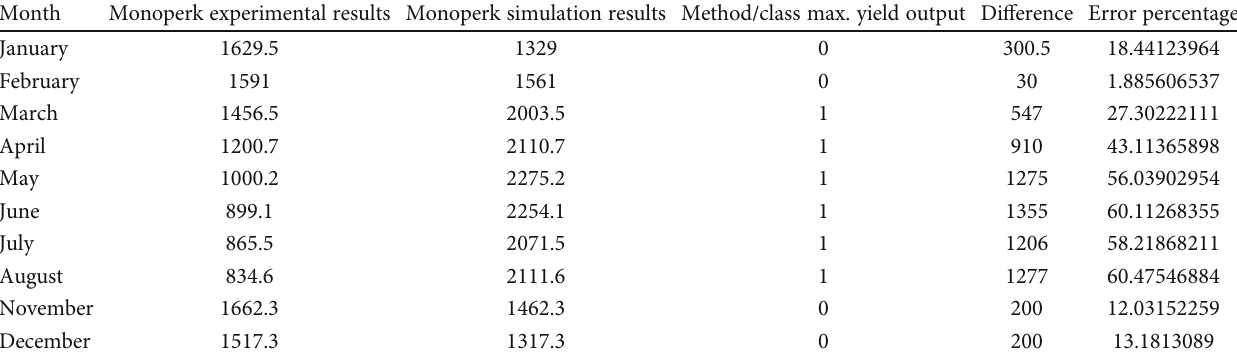
Table 6: Data set of monoperk crystalline module in simulation and experimental work.